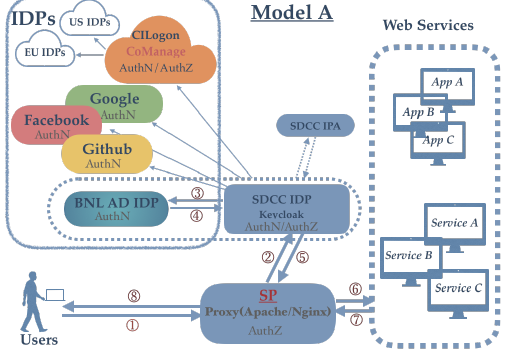
Figure 5. Web reverse proxy based service provider gating access to back end web